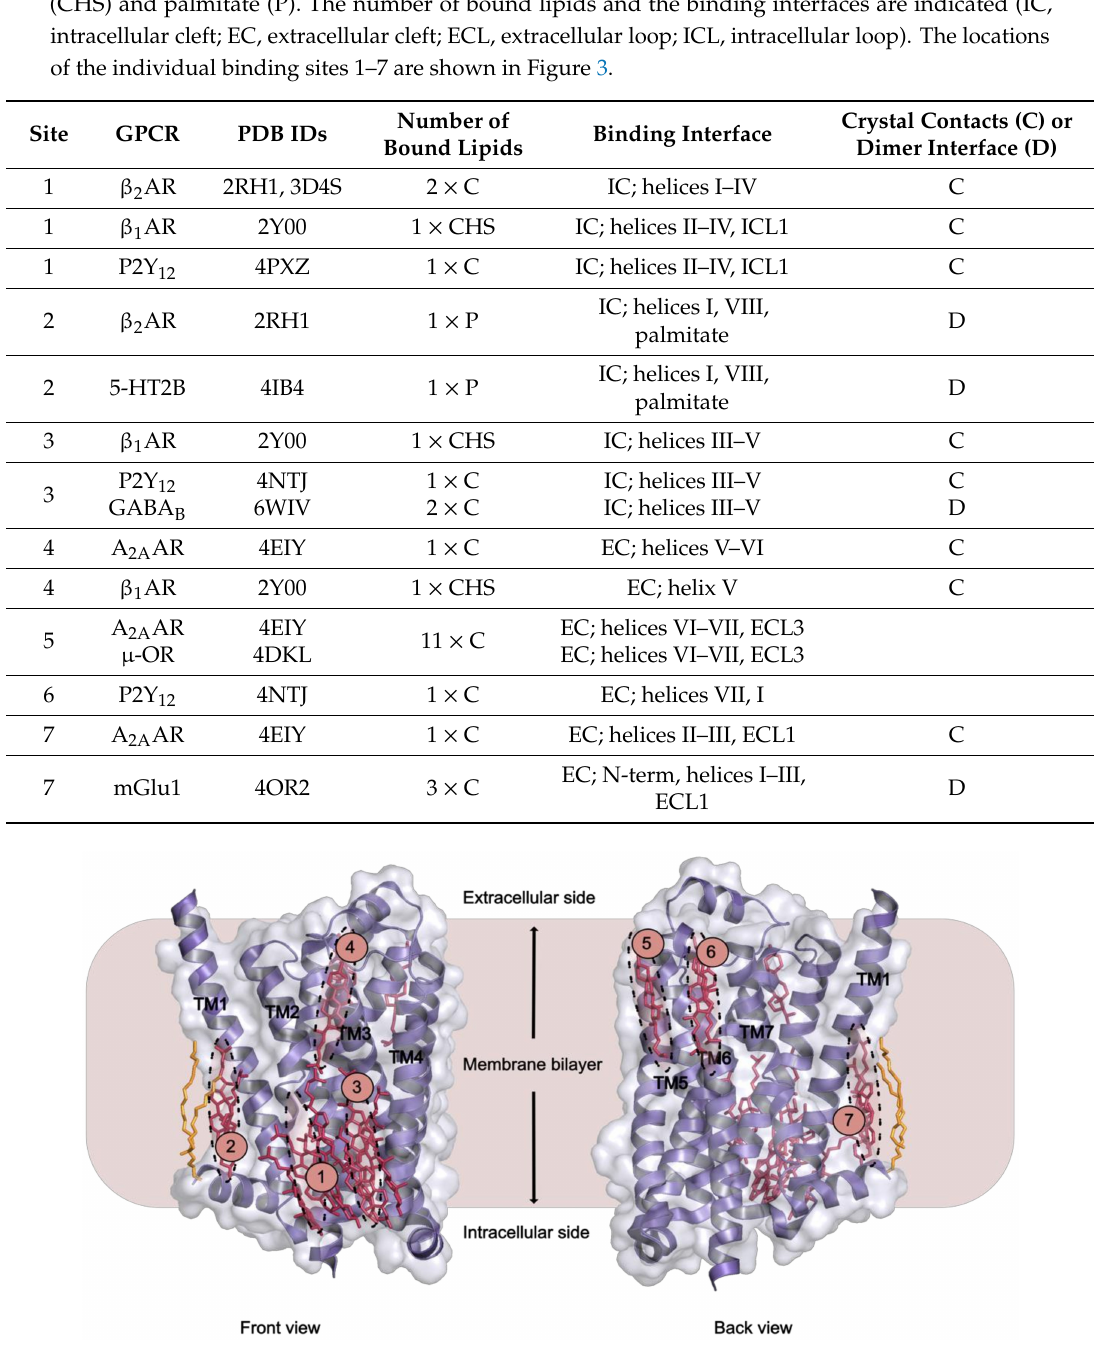
Figure 3. Cartoon overlay of GPCR crystal structures showing di ff erent cholesterol binding sites found (PDB accession codes: 2RH1, 3D4S, 4PXZ, 4IB1, 4NTJ, 6WIV, 4EIY, 4DKL, and 4OR2). Structures are aligned with β 1 AR (PDB accession code: 2Y00). The locations of the lipid binding sites are numbered according to Table 1. Cholesterol and cholesteryl hemisuccinate molecules are shown in red (binding sites 1–7), and the palmitoyl lipids are displayed in orange (binding site